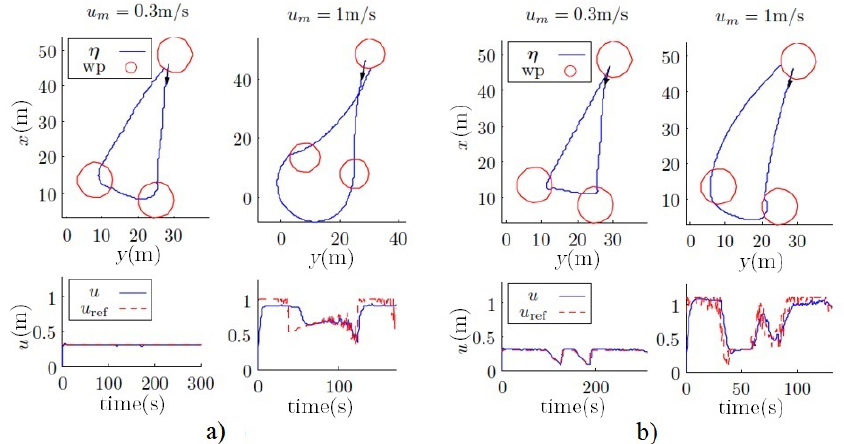
Figure 25. ( a ) Responses using the pure pursuit regarding the radius of curvature. ( b ) Responses using pure pursuit with the fuzzy